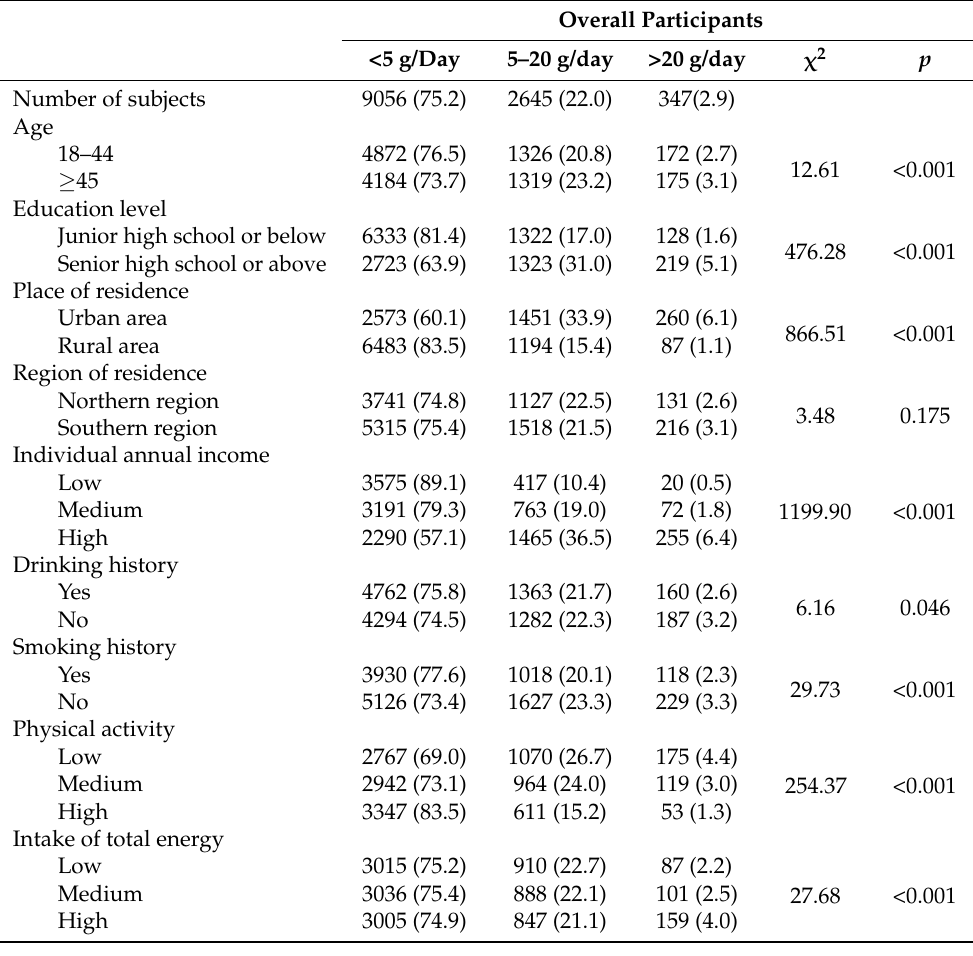
Table 1. Basic characteristics of overall participants according to different levels of free sugars intake,